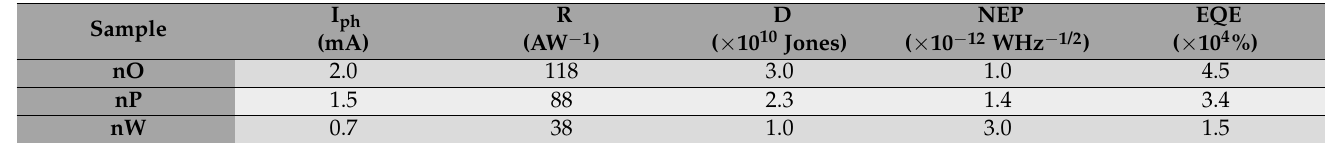
Table 2. A comparison of the performance metrics for fabricated GaN/AlN/Si heterostructure-based device.